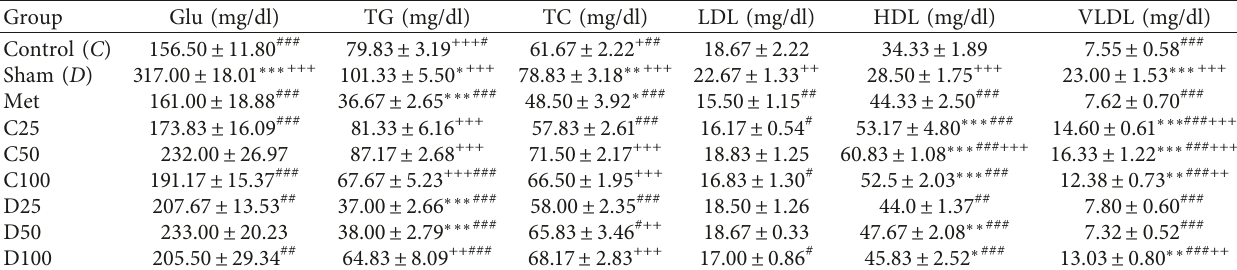
Table 1: Biochemical results of the diabetes rats and